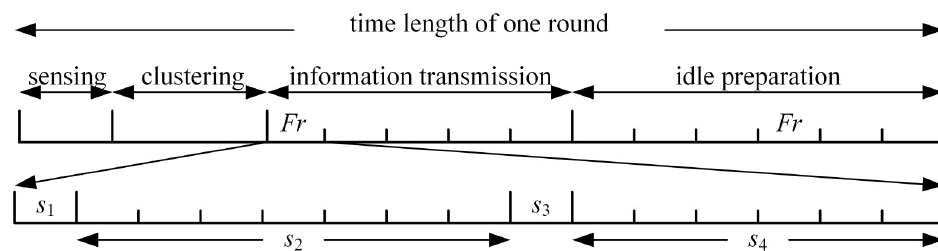
Fig 3. Periodical round structure of